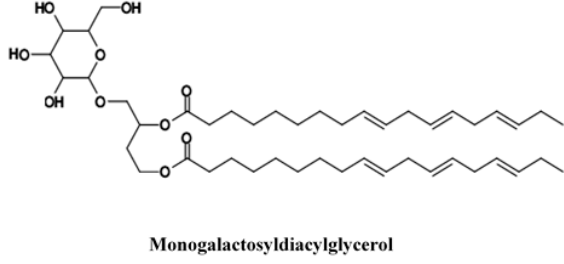
Figure 3. Chemical formula of monogalactosyldiacylglycerol of rose hips.